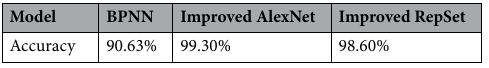
Table 4. Classification accuracy of different